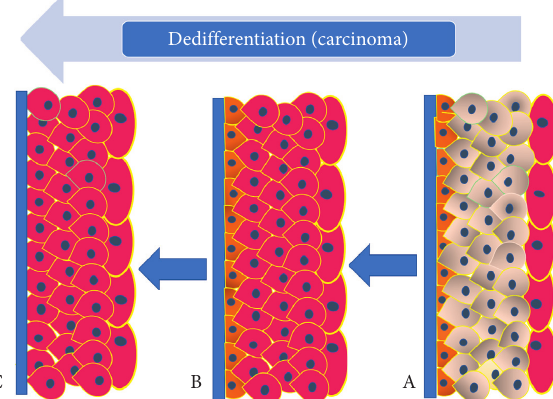
Figure 9: (a) Cartoon depicting immunohistochemical staining pattern in a low-grade papillary urothelial carcinoma with CK20 expression limited to the umbrella cells and presence of a well-defined basal layer which expresses CK5/6. (b) High-grade urothelial carcinoma reveals expression of CK20 in all layers of urothelium except for the basal layer which contains CK5/6. This may represent an intermediate stage of dedifferentiation of the tumor. (c) In high-grade urothelial carcinoma, the basal layer may be absent but the diffuse CK20 pattern of staining is maintained. These features may indicate further dedifferentiation of the